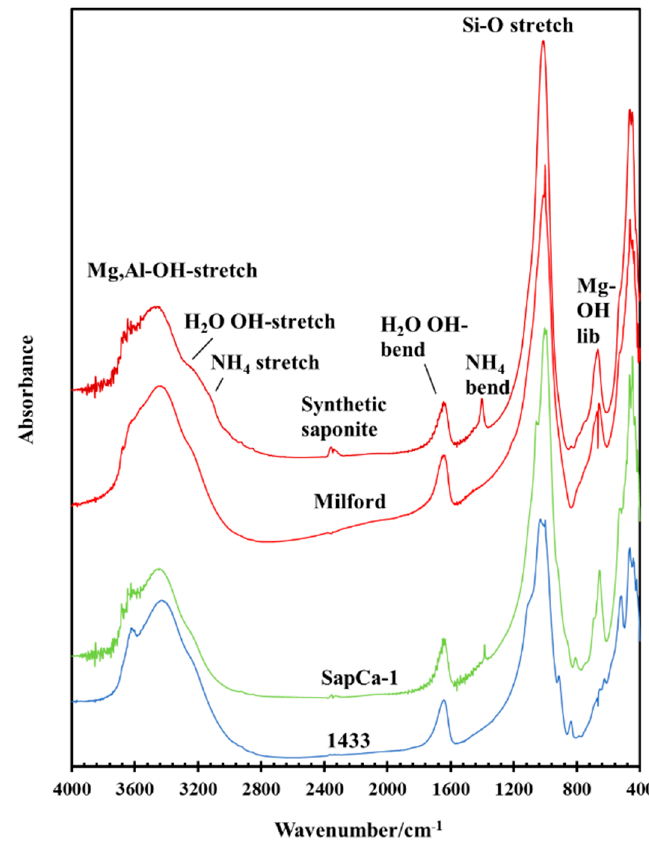
Figure 3. Mid-IR absorption spectra of 3 natural (1433, SapCa-1, Milford) and 1 synthetic NH 4 - saponites